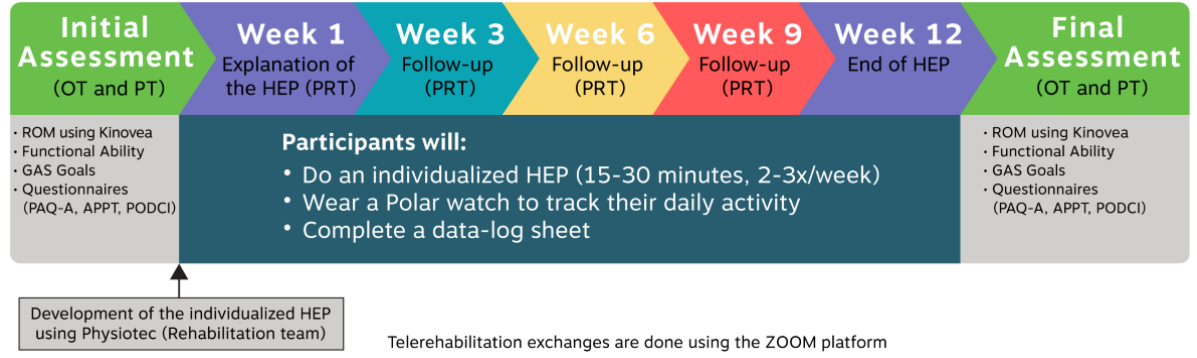
Figure 1. A summary of the 12-week telerehabilitation intervention. APPT: Adolescent and Pediatric Pain Tool; GAS: Goal Attainment Scale; HEP: home-based exercise program; OT: occupational therapist; PAQ-A: Physical Activity Questionnaire for Adolescents; PODCI: Pediatrics Outcomes Data Collection Instrument; PRT: physical rehabilitation therapist; PT: physical